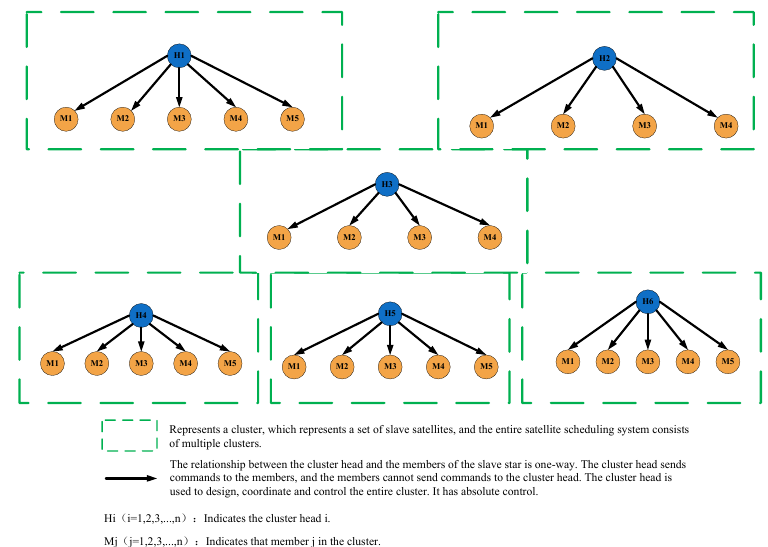
Figure 6. Inter-cluster relationship